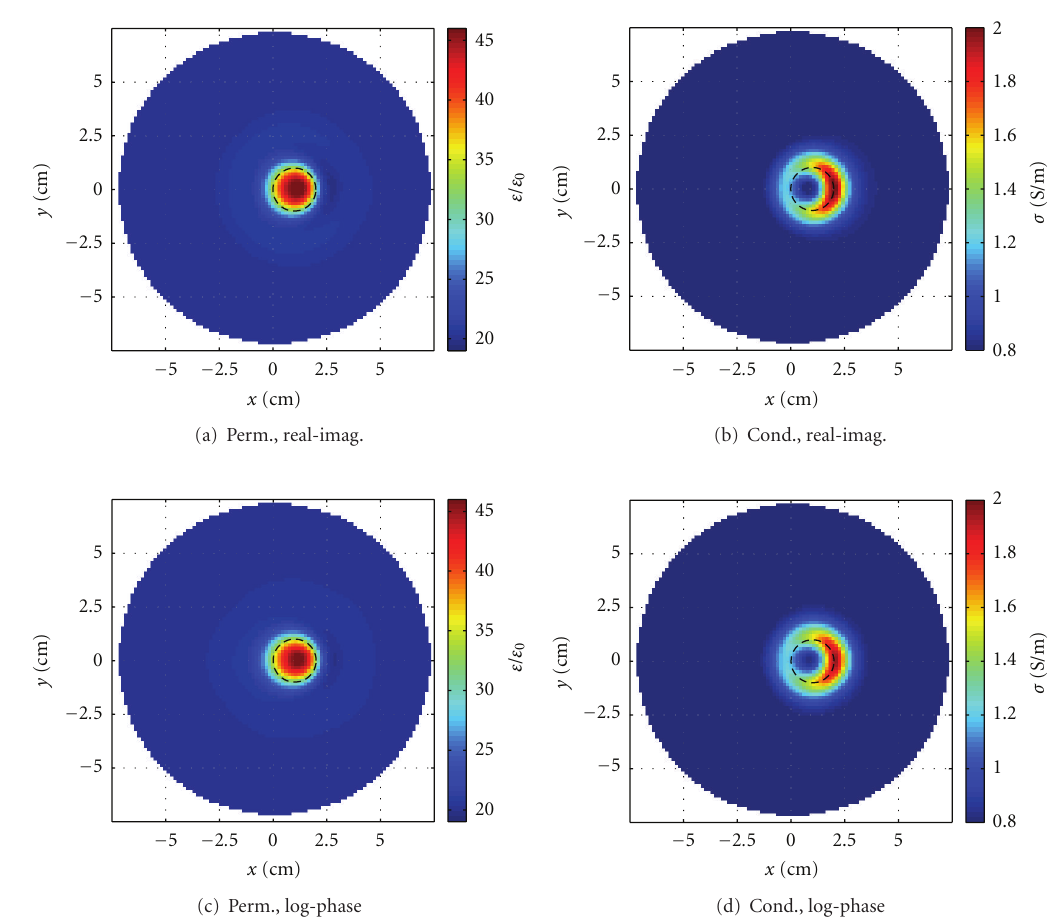
Figure 3: Reconstruction of the simulated measurement of a single target. The dashed lines indicate the position of the scatterer. The two formulations give very similar results—something which is also reflected in the values of the normalized